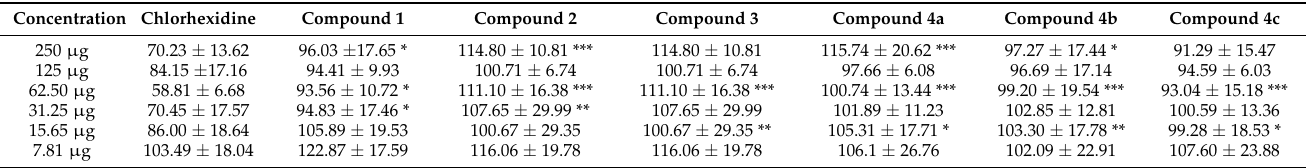
Figure 1. Cytotoxicity analysis of NBA against HEK 293 cells. Table 3. Cytotoxicity values for NBA.